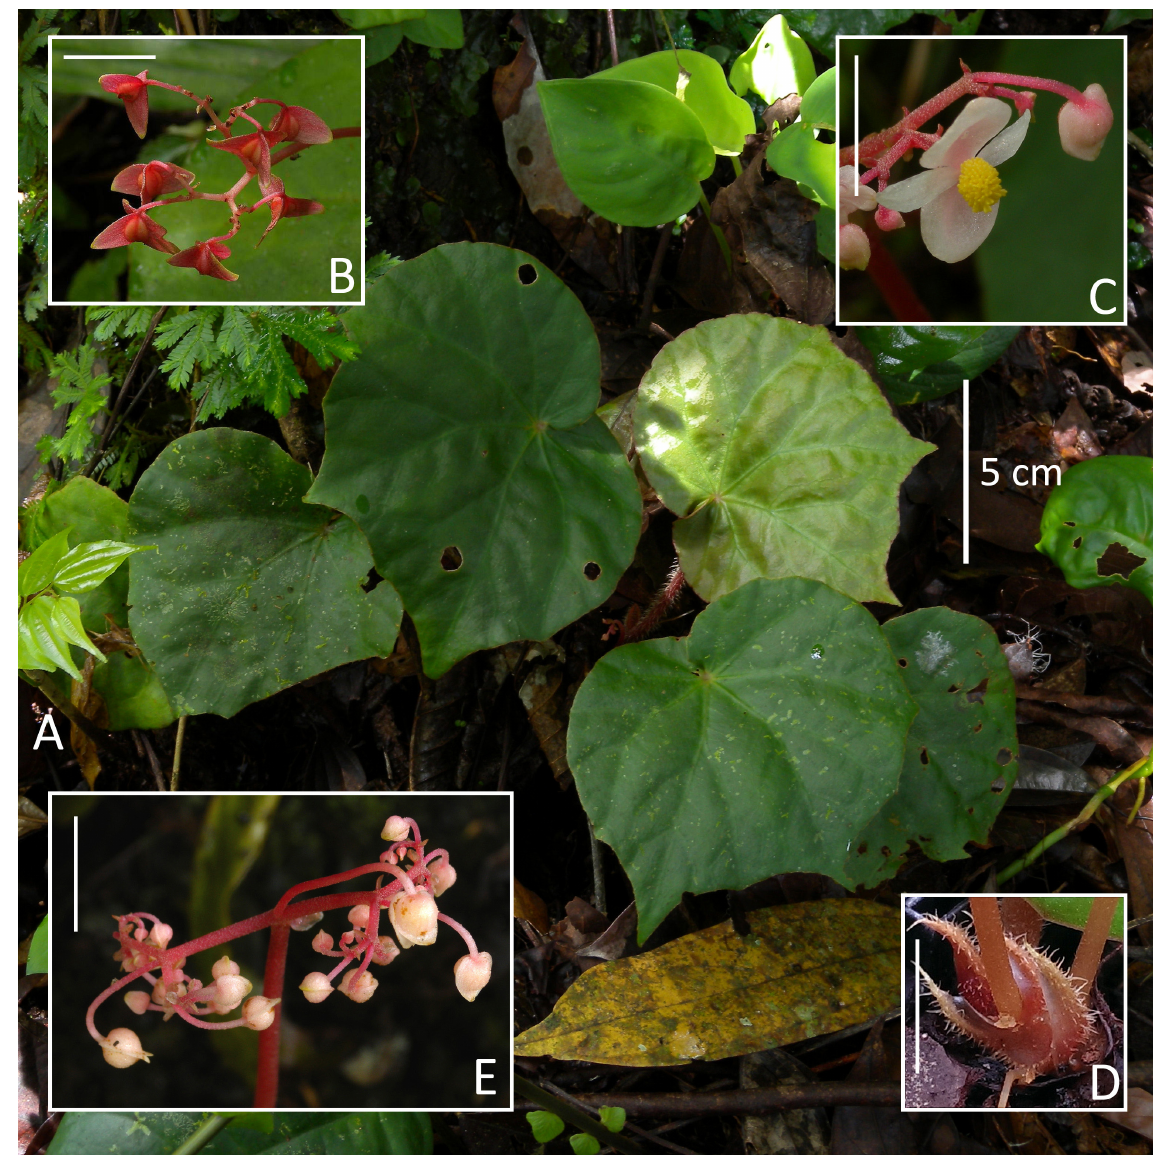
Fig. 9. Begonia kemumuensis M.Hughes sp. nov. A . Habit. B . Fruit. C . Male flower. D . Stipules. E . Young inflorescence. A–C, E from the type locality of Kemumu waterfall; D from a plant in cultivation at the Royal Botanic Garden Edinburgh (accession 20101656, derived from the type DEDEN1506 ). Scale bars on insets = 1